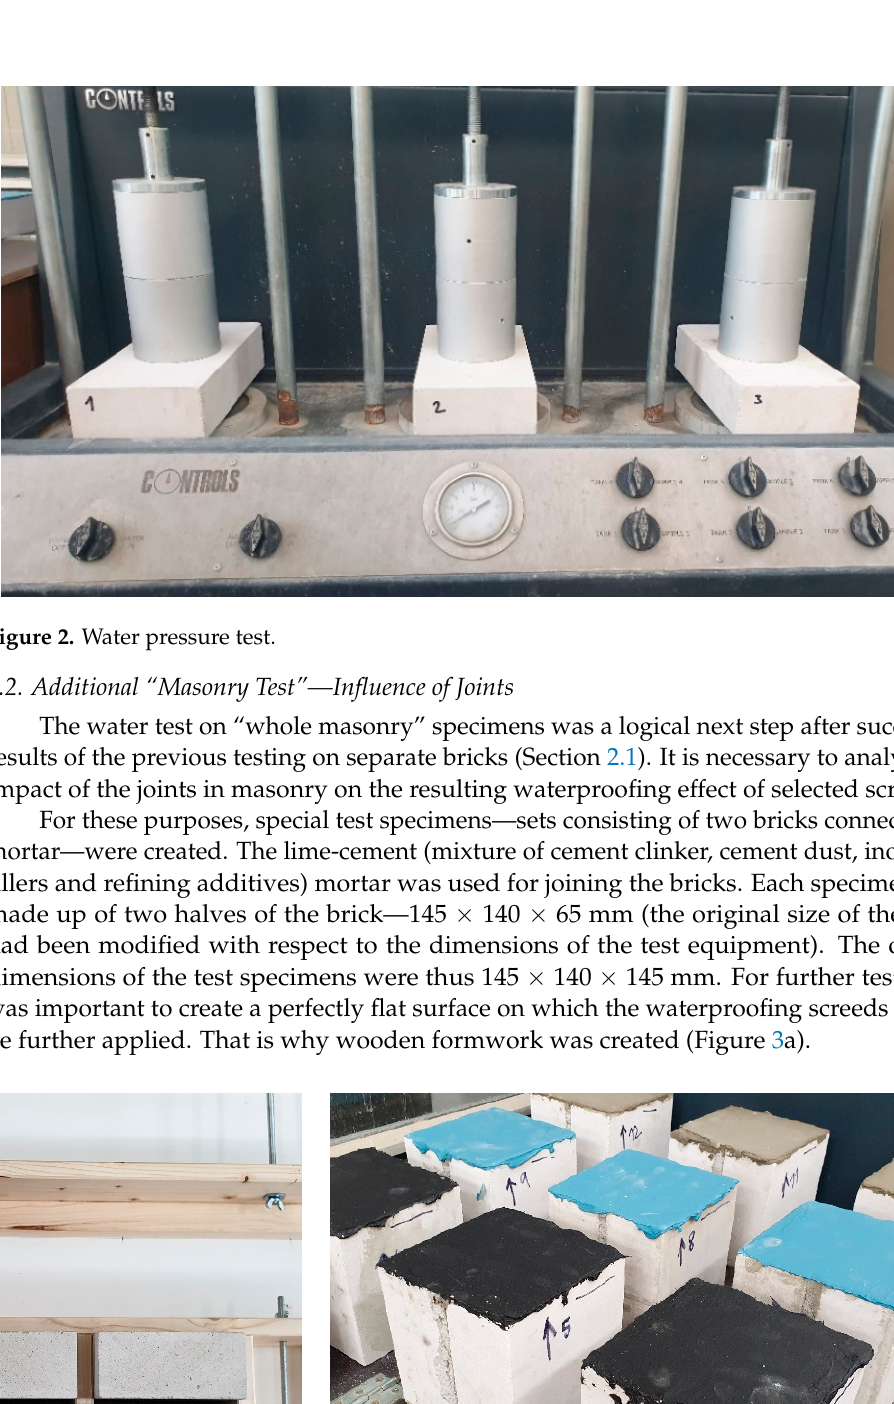
Figure 3. ( a ) Test specimen—lime-sand bricks and lime-cement mortal in wooden formwork; ( b ) test specimens with ap- plied waterproof screeds.